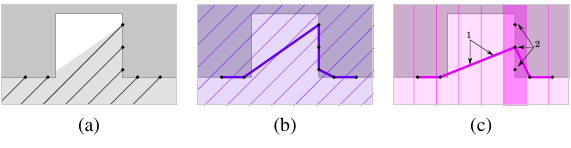
Figure 11: Loss of Accuracy (a) Laser beams partially entering a cavity. (b) The iso- uv (purple) are along the laser beams, points are dis- tion for surface reconstruction: there is one point per pixel, there (c) Orthogonal projection, iso- uv (pink) orthogonal to the wall.